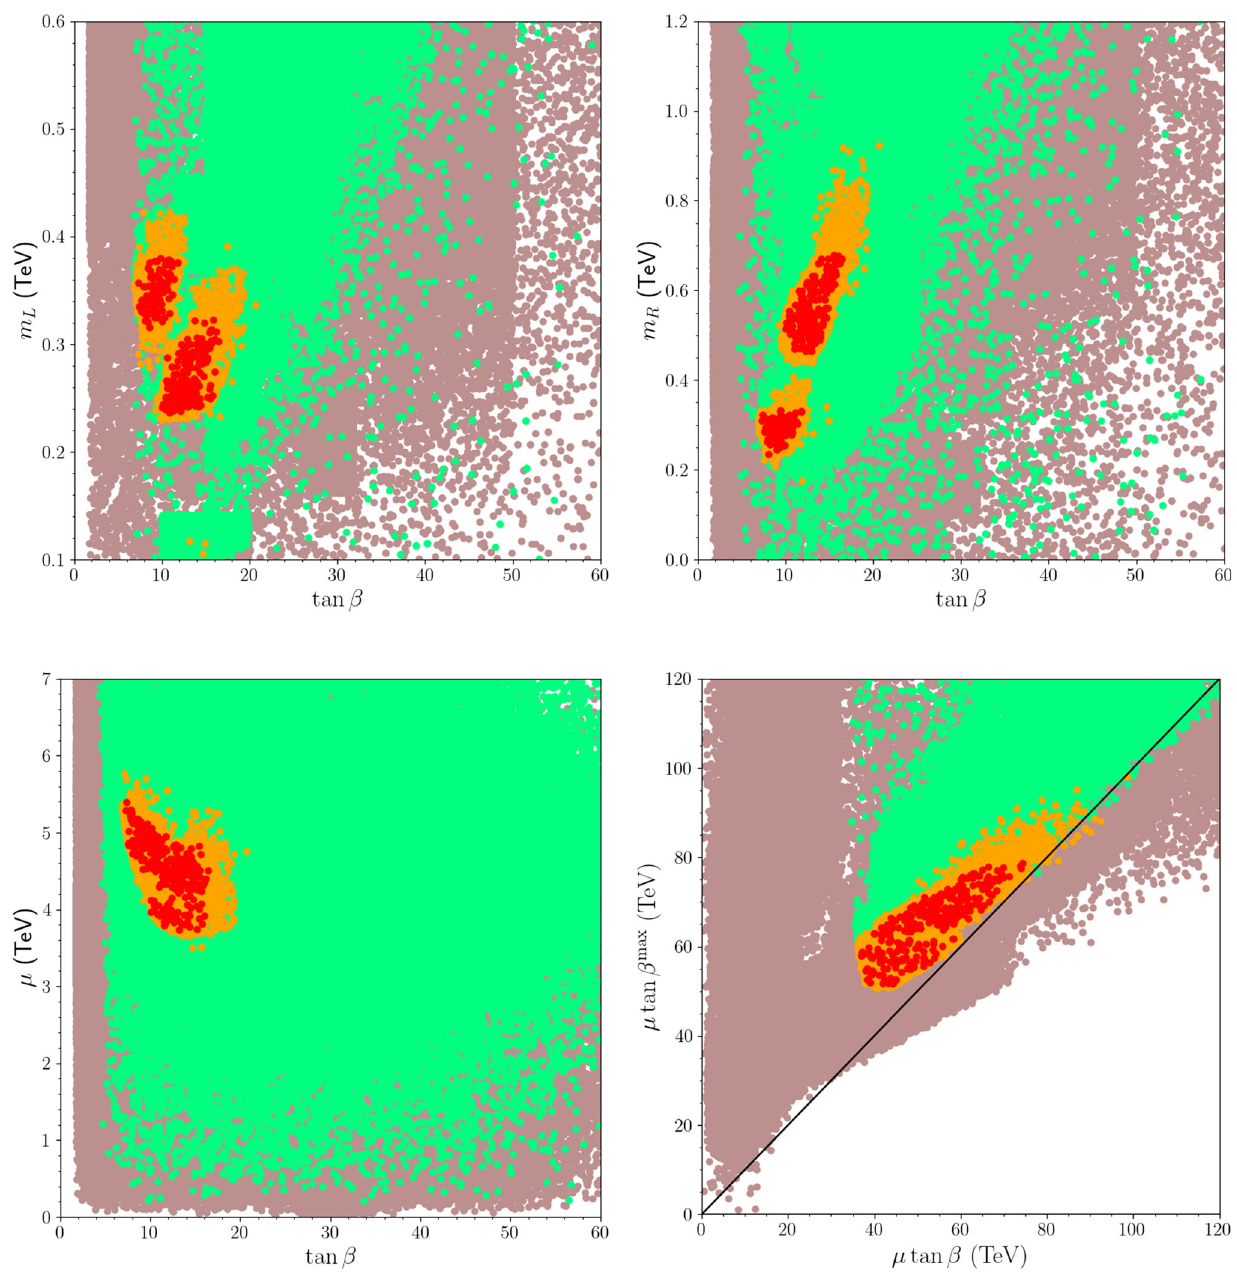
Fig. 6 The vacuum stability in 4 − 2 − 2 with plots in the m L − tan β , m R − tan β , μ − tan β and μ tan β max − μ tan β planes. All points are compatible with the REWSB and LSP neutralino conditions. Green points are allowed by the mass bounds and constraints from rare B - meson decays. The orange points form a subset of green, and they accommodate the resolution to the muon g − 2 discrepancy within 2 σ .